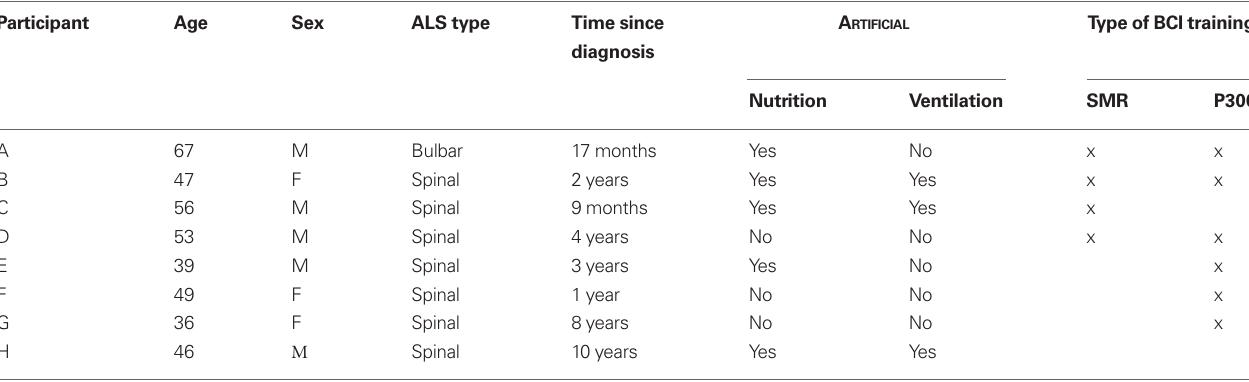
Table 1 | Demographic data and illness parameters of participants, and type of BCI used for